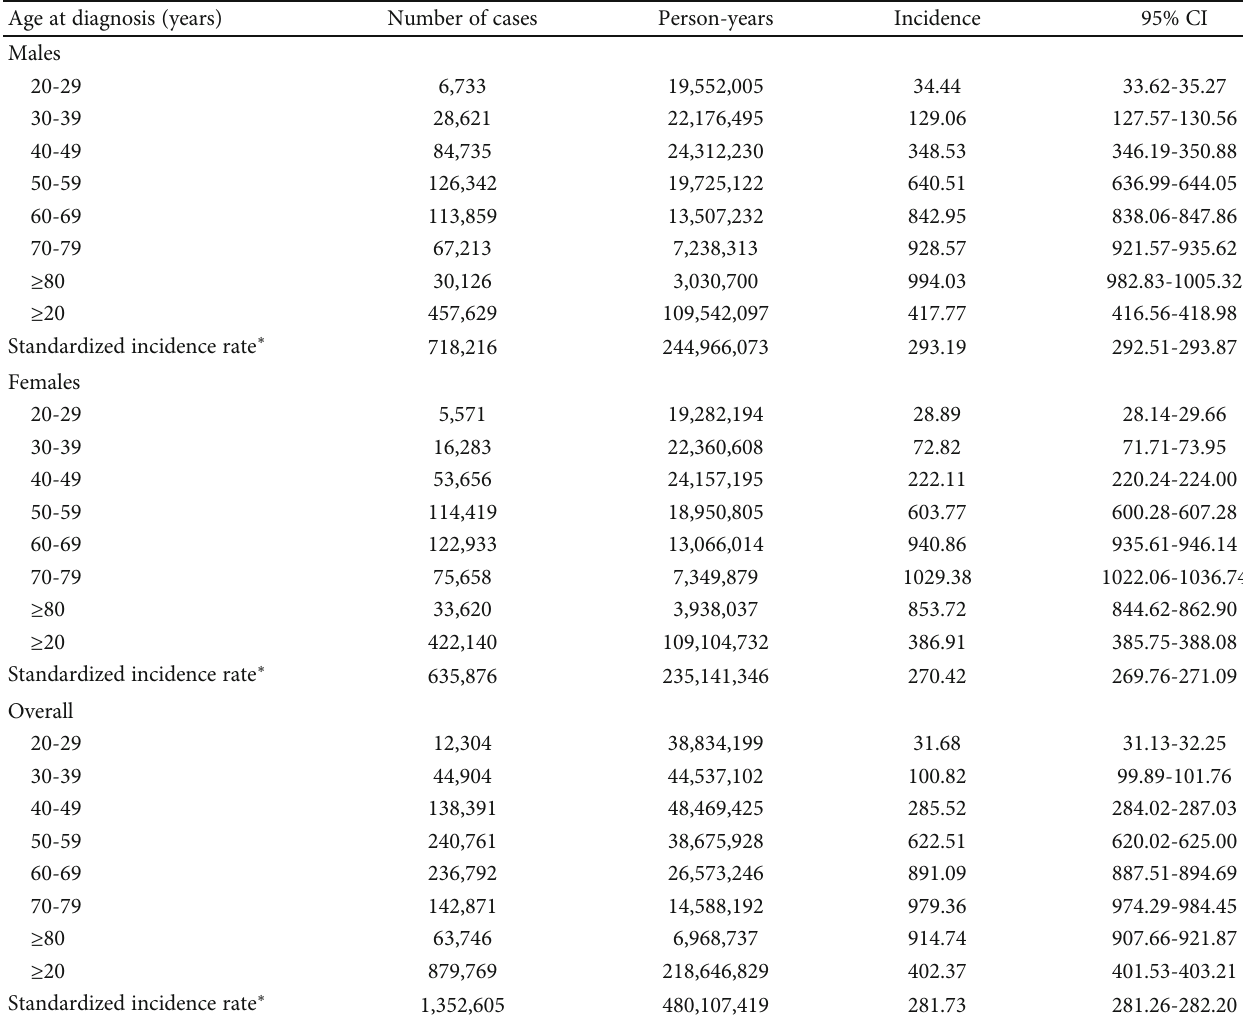
Table 2: Mean incidence rate of type 2 diabetes, 2007-2017 (per 100,000 person-years). Age at diagnosis